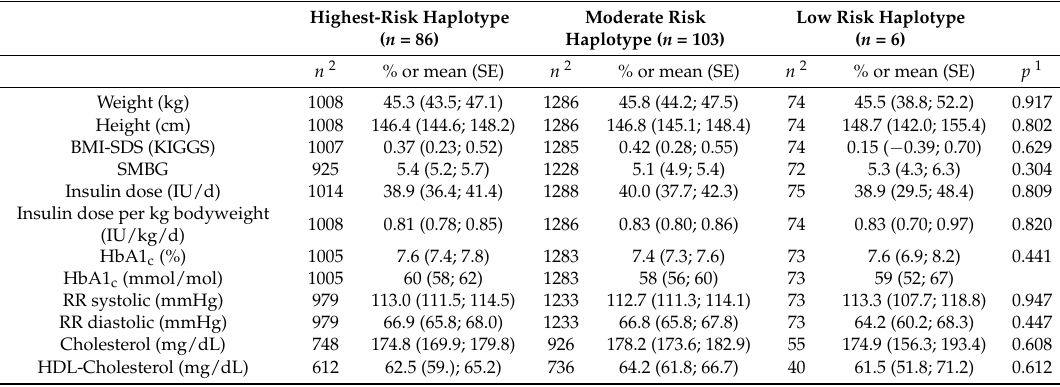
Table 3. Adjusted comparisons of clinical data of patients with the highest-risk haplotype combination ( HLA-DRB1*03:01-DQA1*05:01-DQB1*02:01/DRB1*04-DQA1*03:01-DQB1*03:02 ) vs.